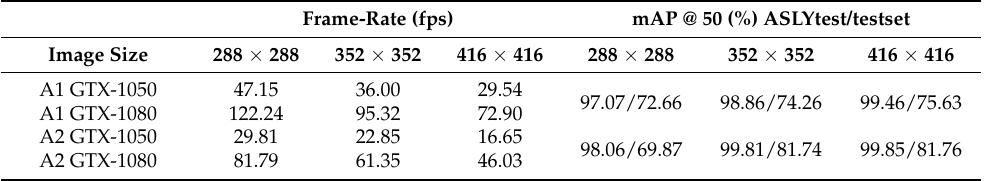
Table 2. YOLO Network models